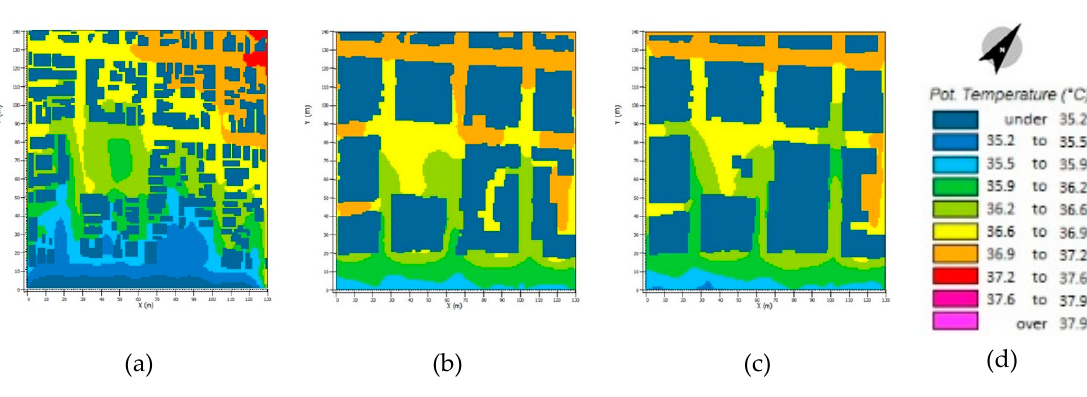
Figure 5. Air temperature (Ta) results for January 2018 (average), 8 p.m.: ( a ) Sprawl Morphology (urban form data: 1930); ( b ) Medium Morphology (urban form data: 1950); ( c ) Density Morphology (urban form data: 2018); and ( d ) Color scale.